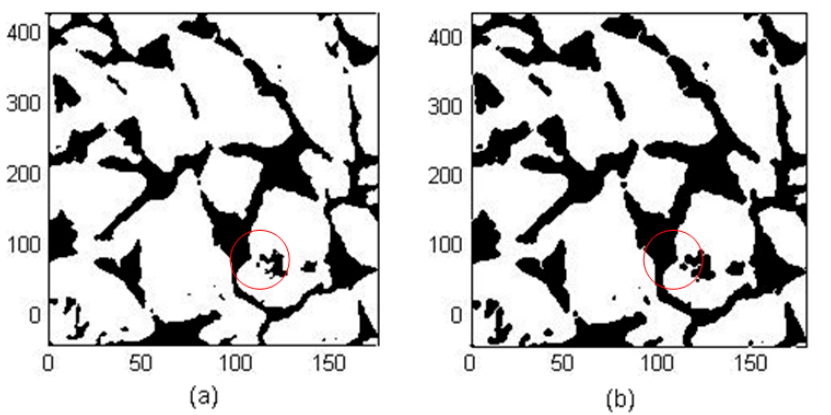
Figure 5. ( a ) Binary image; ( b ) smoothed binary image.